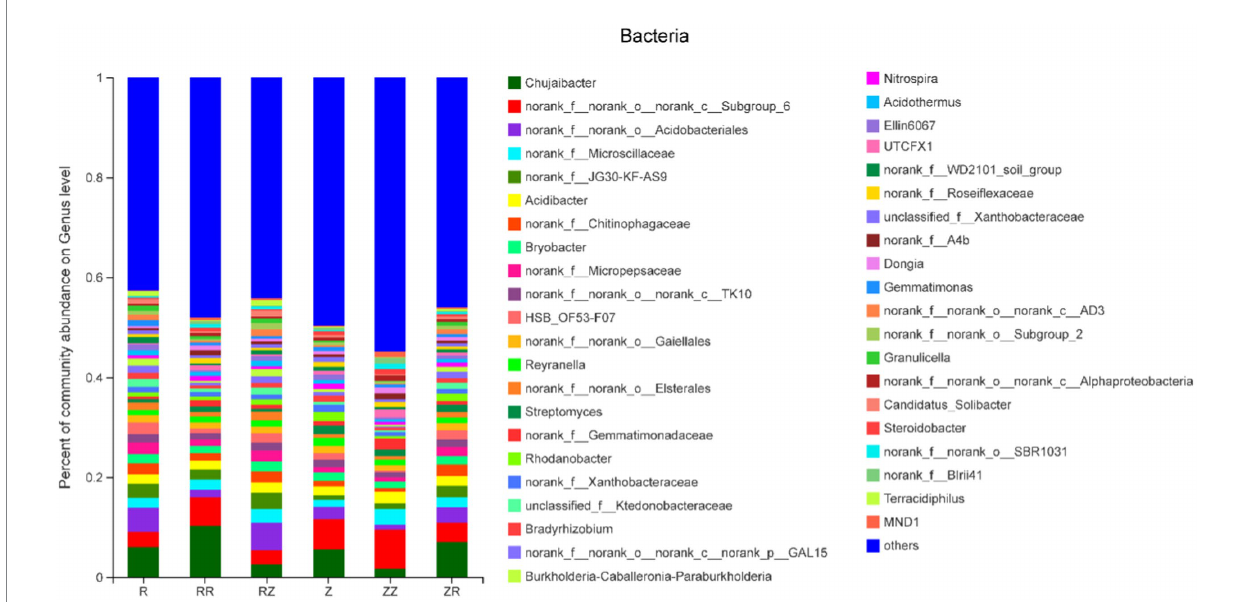
FIGURE 2 Response of sugarcane straw returning on the relative abundance (% total reads) of bacterial community at the genus level of different sugarcane cultivars R: cultivar ROC22, RR: cultivar ROC22 plus straw of ROC22; RZ: cultivar ROC22 plus straw of Zhongzhe9; Z: cultivar Zhongzhe9; ZZ: cultivar Zhongzhe9 plus straw of Zhognzhe9; ZR: cultivar Zhongzhe9 plus straw of ROC22. ‘Other’ was the sum of genera that relative abundance was lower than 1%.